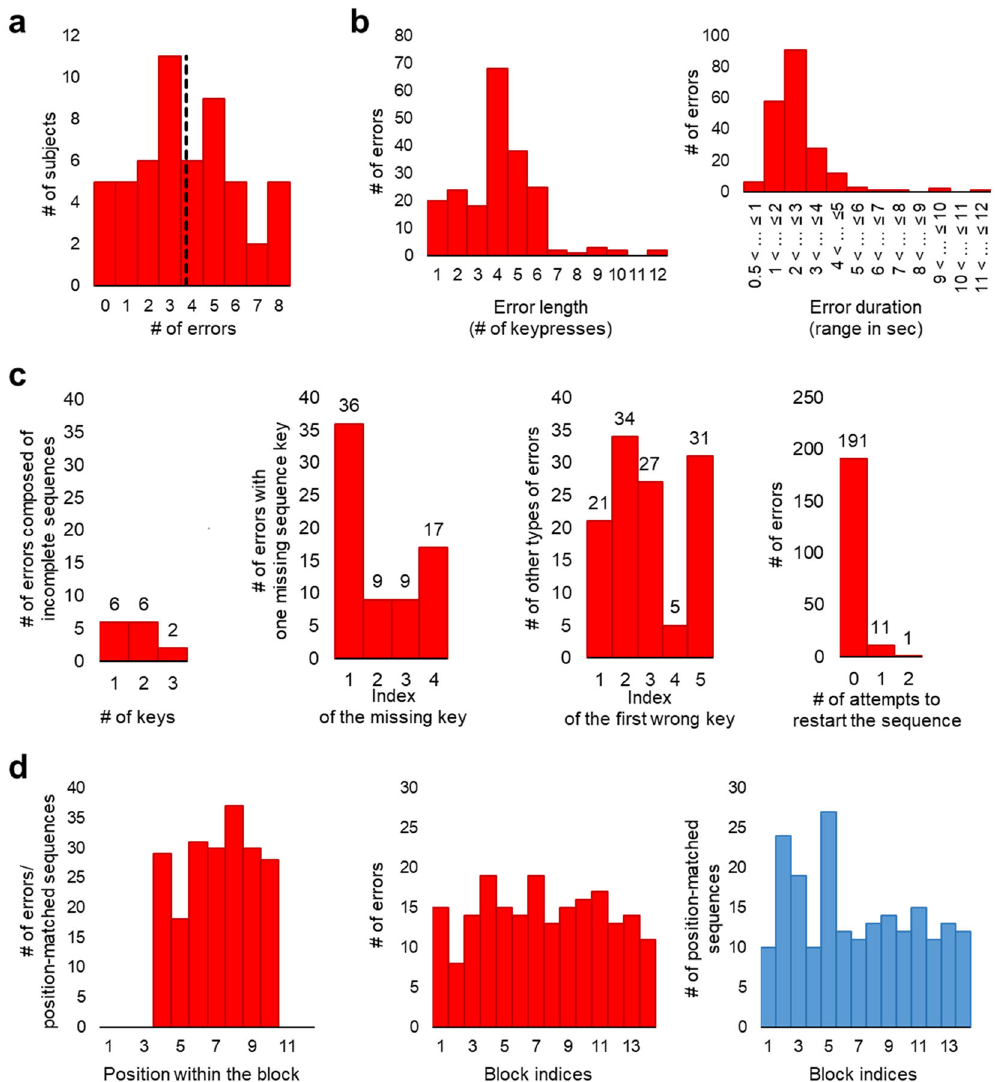
Fig. 2 Sample summary for errors of interest and position-matched sequences. a The distribution of number of errors across participants. The vertical dashed line represents the group mean of the number of errors. b The number of errors plotted against their length (i.e., the number of keypresses within the error) and duration (i.e., the total time spent on the error starting from its onset until its offset). The vast majority of errors comprise between 1 and 6 keypresses, and last <6 s. c The distribution of errors by different types and the number of attempts to reinitiate correct task performance. Here, incomplete sequences are instances of correctly initiated, but un fi nished sequence with up to three correctly pressed keys. Un fi nished sequences with four correct keys are labeled as errors with one missing key. An attempt to restart the sequence is determined by the fi rst sequence transition, i.e., the key combination of 4 – 1. d The distribution of errors/position-matched sequences within and across performance blocks. Note, that errors and position- matched sequences have the same distribution within